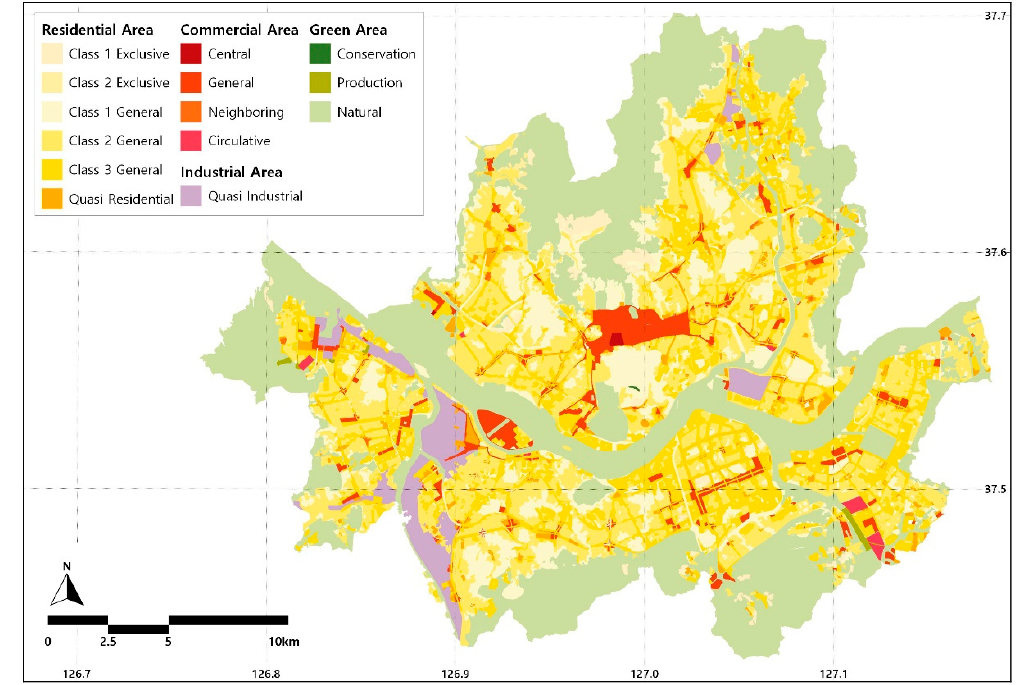
Figure 1. Special-Purpose Area (SPA) of Seoul.